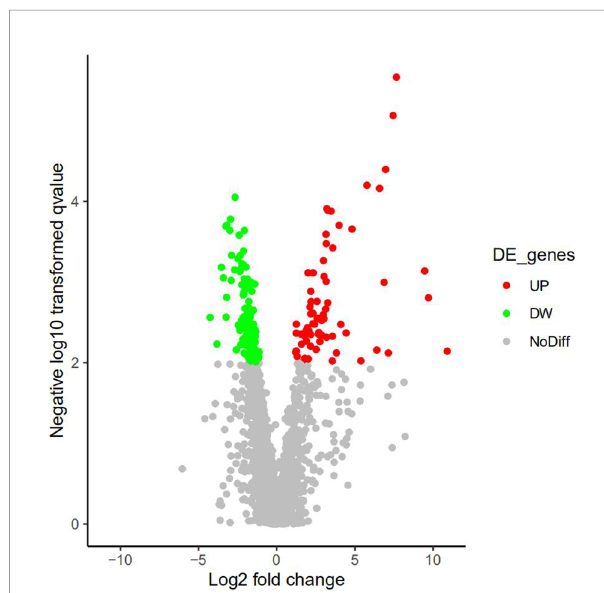
FIGURE 2 | Active volcano map of proteins, screening criteria of DEPs: P.value<0.05 and Log|logFC|>1. Red dots represent upregulated proteins, and the green dots represent downregulated proteins. Gray dots mean these proteins do not satisfy the screening criteria. X-axis represents Log2|FC|, and the y-axis represents -Log10|P-value|.